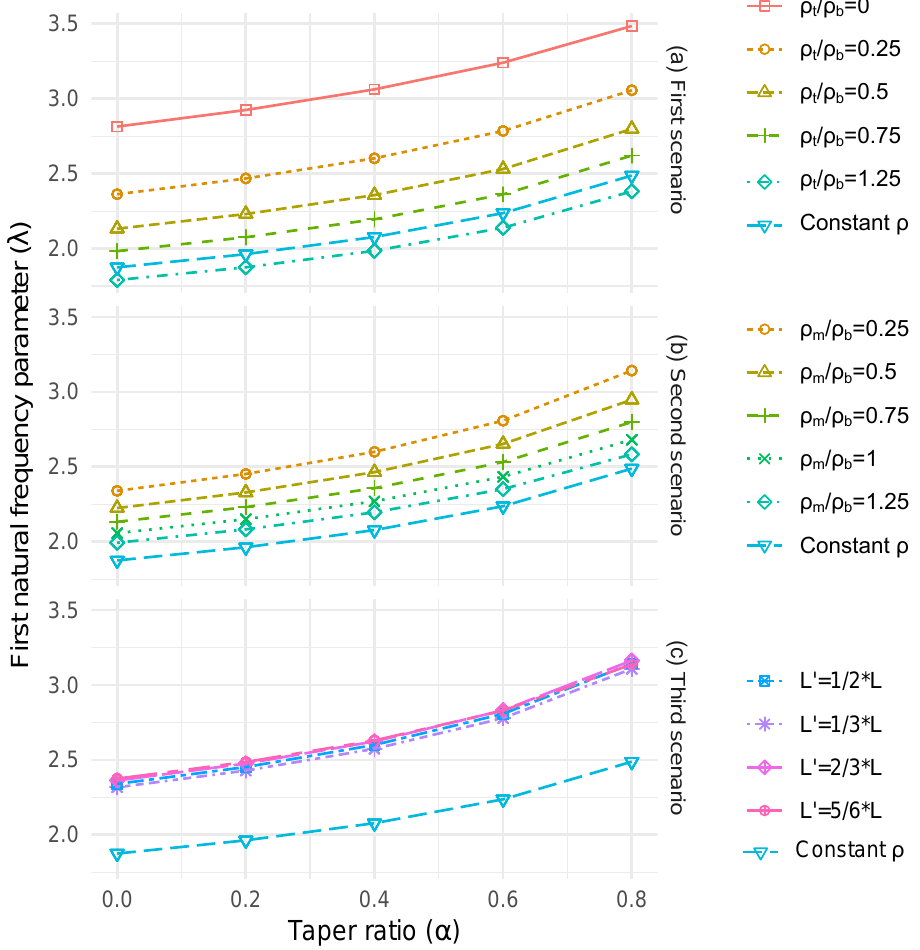
Figure 7. ( a ) taper ratio versus first natural frequency parameter ratio with longitudinal density variation linearly from the bottom to the top end of the tree (first scenario), ( b ) taper ratio versus first natural frequency parameter ratio with longitudinal density variation linearly from the bottom to the half of the tree height, followed by a linear variation till the top end of the tree (second scenario) and ( c ) taper ratio versus first natural frequency parameter ratio with longitudinal density variation linearly from the bottom to L’, followed by a linear variation till the top end of the tree (third